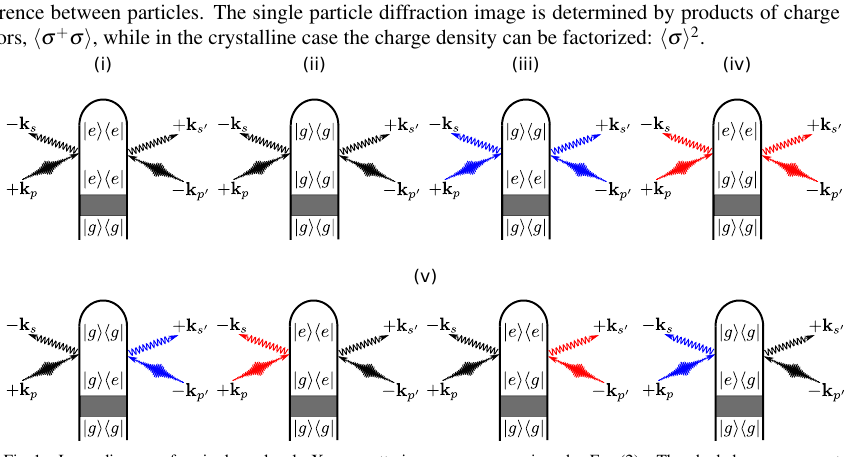
Fig 1. Loop diagrams for single-molecule X-ray scattering processes as given by Eq. (2). The shaded area represents preparation with a pump-pulse. Diagrams for elastic scattering from e and g is shown in (i) and (ii) respectively, while the diagrams for inelastic scattering from e and g are displayed in (iii) and (iv). The bottom row (v) represents all diagrams involving to electronic coherences. Elastic scattering processes come with ˆ σ gg or ˆ σ ee and are denoted by black field arrows.